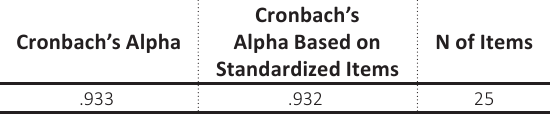
Table 2. Reliability